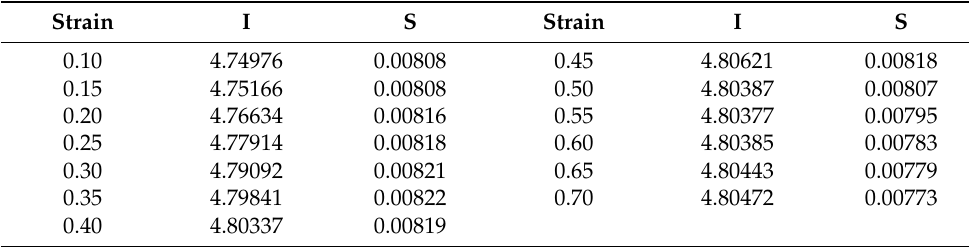
Figure 10. Flow chart for solving MZA model parameters. Table 4. Values of I and S at different strains.